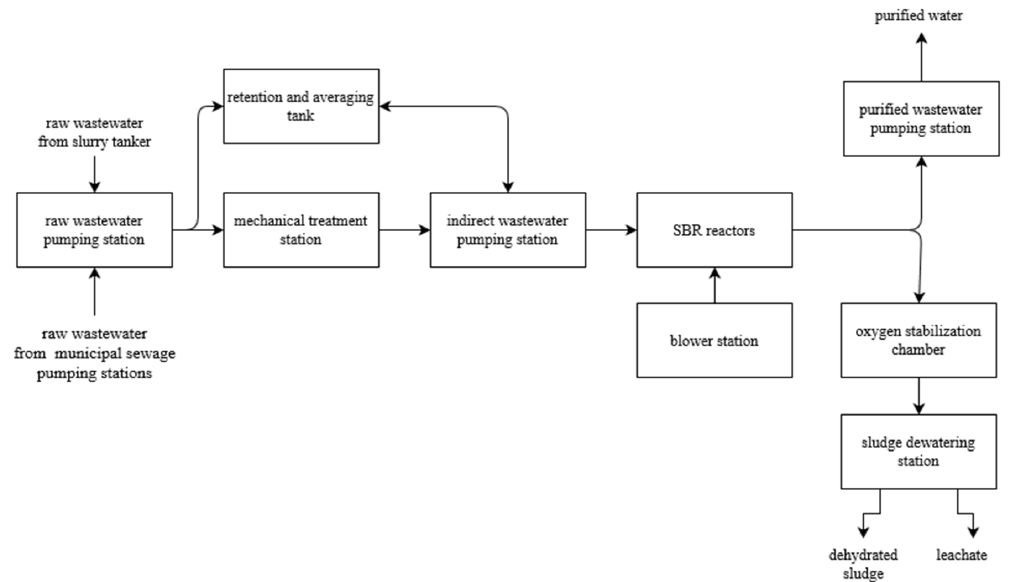
Figure 1. Schematic diagram of WWTP (wastewater treatment plant) at Matowskie Pastwiska. WWTP is composed of two identical SBRs which operate independently of each other. Each SBR is equipped with a separate aeration system, which consists of a blower, membrane diffuser units, and pipeline. The schematic diagram of the aeration system is shown in Figure 2.